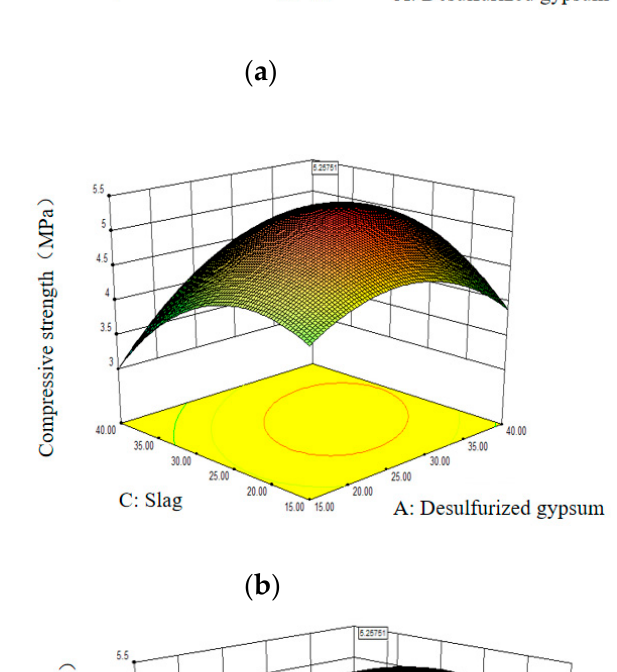
Figure 2. Response surface analysis results of different materials. ( a ) Desulfurized gypsum and fly ash. ( b ) Desulfurized gypsum and slag powder. ( c ) Fly ash and slag powder.